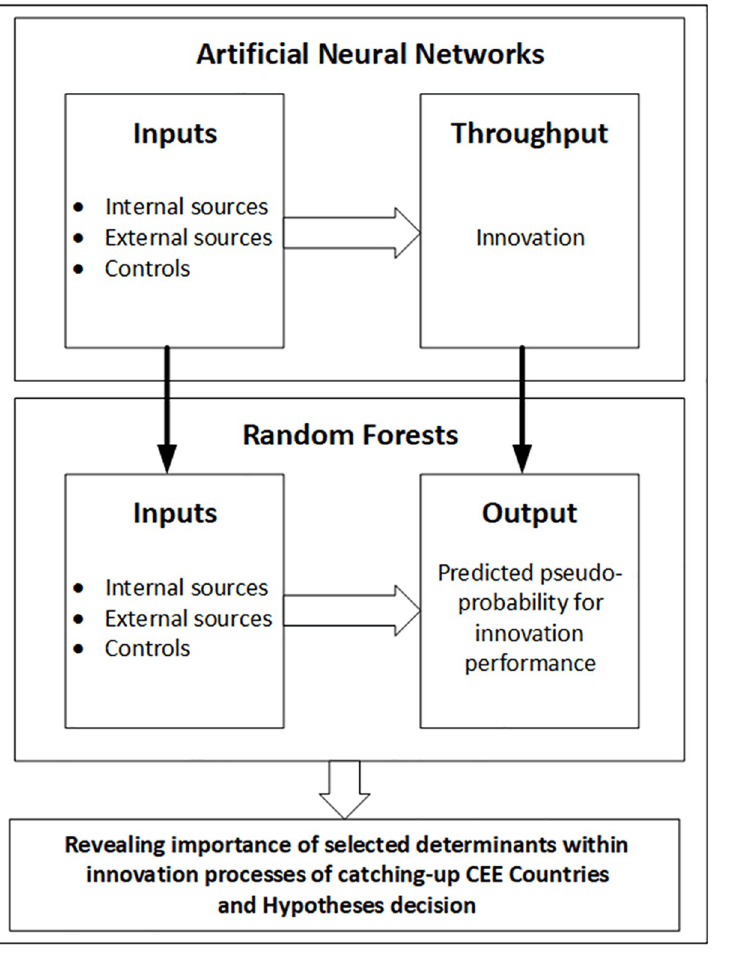
Fig 1. Proposed two-staged ANN-RF